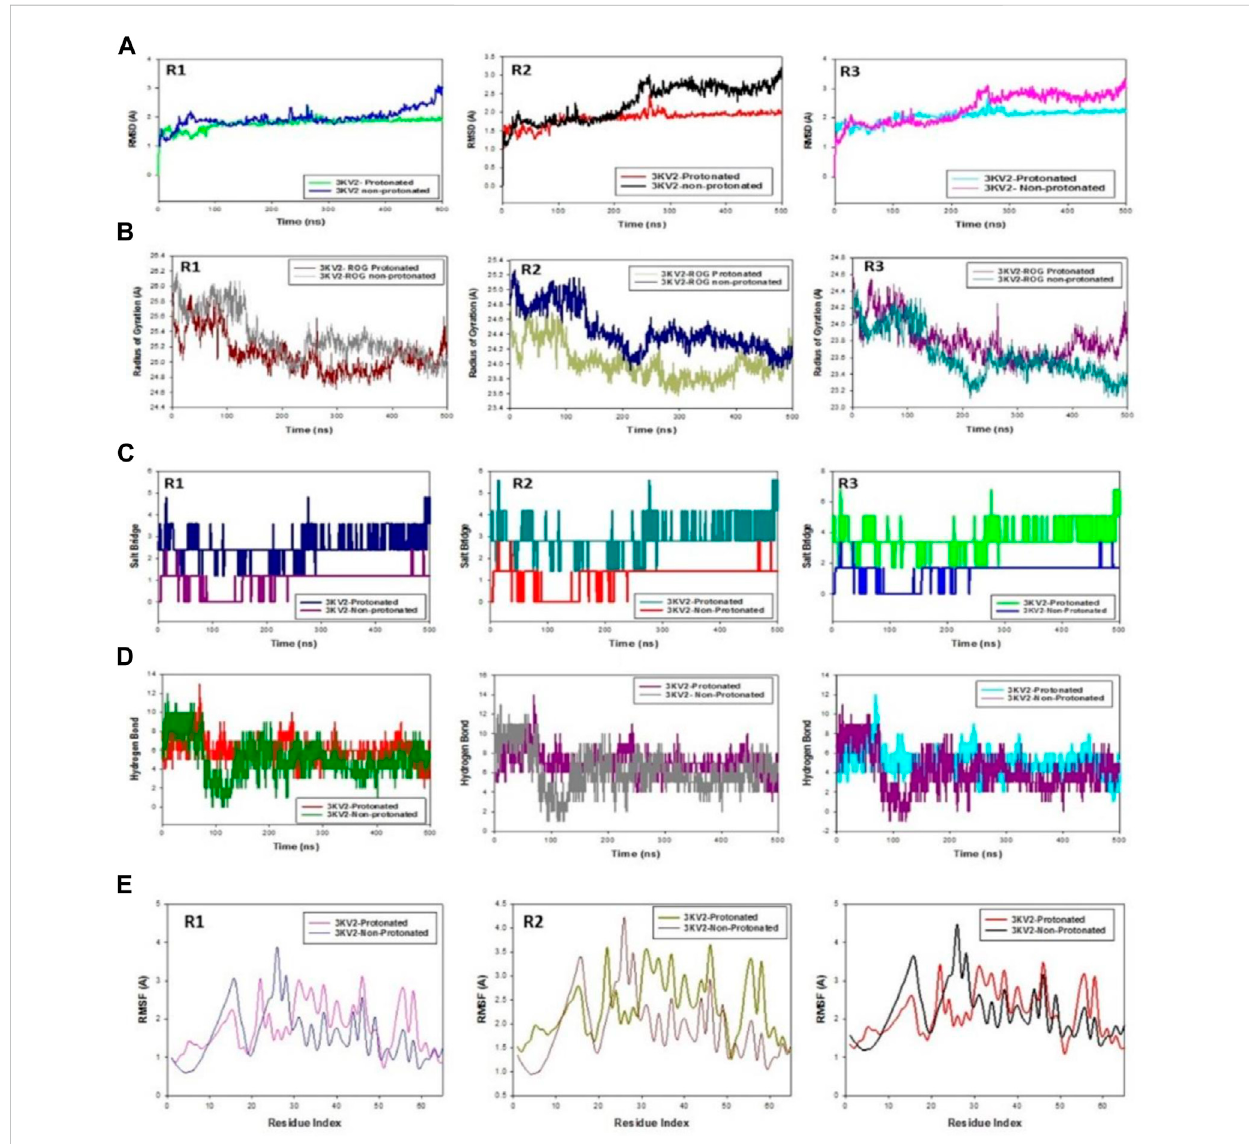
FIGURE 12 (A) MD simulation trajectory analysis of RMSD of ZINC000252286875 boundwith 3KV2, i.e., Arginase-1,500 ns time frame in triplicate displayed: R1 (replicate 1) RMSD plot of ZINC000252286875 bound Arginase-1 (PDB I.D: 3KV2) in Protonated (green) versus non-Protonated protein Arginase-1 (PDB I.D: 3KV2) (blue); R2 (replicate 2) RMSD plot of ZINC000252286875 bound Arginase-1 (PDB I.D: 3KV2) R1 (replicate 1) ROG plot of ZINC000252286875 bound Arginase-1 (PDB I.D.: 3KV2) in protonated state (light grey) versus non-protonated bound protein Arginase-1 (PDB I.D.: 3KV2) (chocolate brown); R2 (replicate 2) Arginase-1 (PDB I.D.: 3KV2) in protonated state (navy blue) with non-protonated bound Arginase-1 (PDB I.D.: 3KV2) (light olive); R3 (replicate 3) ROG plot of ZINC000252286875 bound Arginase-1 (PDB I.D.: 3KV2) in protonated state (pink) with non-protonated bound proteinC.MD simulation trajectory analysisof Salt Bridgeof ZINC000252286875 bound with Arginase-1 inprotonatedstate (PDB I.D.:3KV2)with non-protonated state at 500 ns time frame in triplicate displayed: R1 (replicate 1) ZINC000252286875s Salt Bride plot is bound. Arginase-1 (PDB I.D.: 3KV2) in protonated state (PDB I.D.: 3KV2) (navy blue)with non-protonated bound protein R2 (replicate 2) Salt bridge plot of ZINC000252286875 bound Arginase-1 (PDB I.D.: 3KV2) in protonated state (teal) versus non-protonated bound state with protein Arginase-1 (PDB I.D.: 3KV2) (red); R3 (replicate 3) SaltBridgeplotofZINC000252286875boundArginase-1(PDBI.D.:2ZHV)inprotonatedstate(limegreen)withproteinArginase-1(PDBI.D.:3KV2)(blue); (D) MDsimulationtrajectoryanalysisofArginase-1(PDBI.D.R1(replicate1)R2(replicate2)H-bondplotofZINC000252286875boundprotonatedligand (red) and non-protonated ligand (green) with Arginase-1 (PDB I.D.: 3KV2) (red). R3 (replicate 3) H-bond plot of ZINC000252286875 bound protonated ligand (dark grey) and non-protonated ligand (magenta) with Arginase-1 (PDB I.D.: 3KV2). ZINC000252286875 H-bond plot with Arginase-1 bound protonatedligand(cyan)andnon-protonatedligand(magenta)(PDBI.D.:3KV2).R1(replicate1)RMSFplotofZINC000252286875boundArginase-1(PDB I.D: 3KV2) in protonated form (magenta) and non-protonated bound form with protein Arginase-1 (PDB I.D: 3KV2) (blue); R2 (replicate 2) RMSF plot of ZINC000252286875 bound Arginase-1 (PDB I.D: